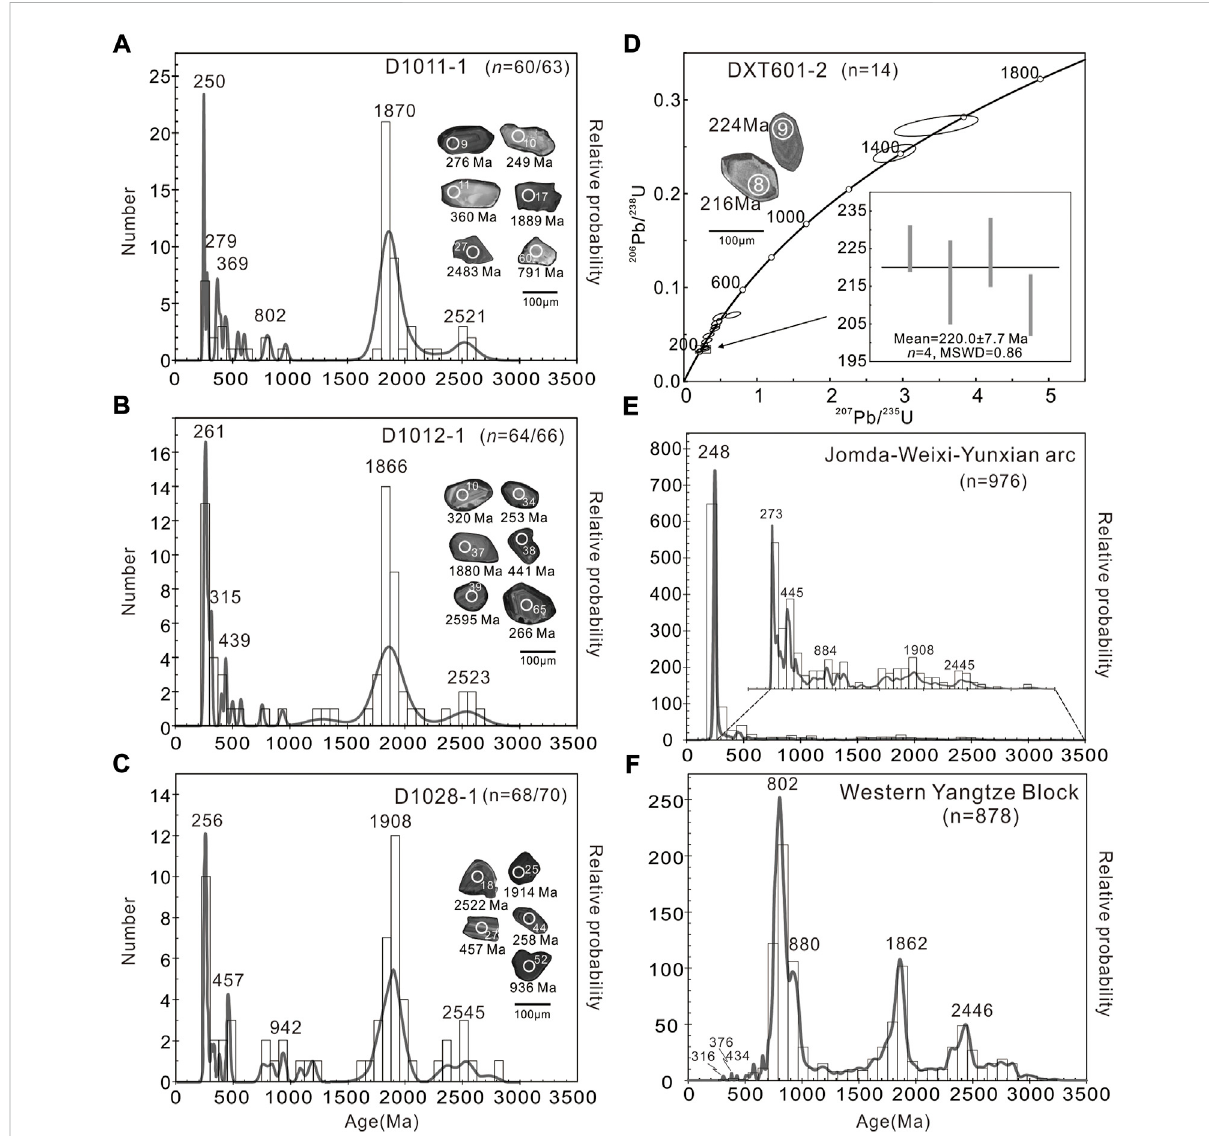
FIGURE 7 (A – C) Probability histograms of detrital zircon U-Pb ages of sandstone samples of the Maichuqing Formation. (D) Zircon U-Pb